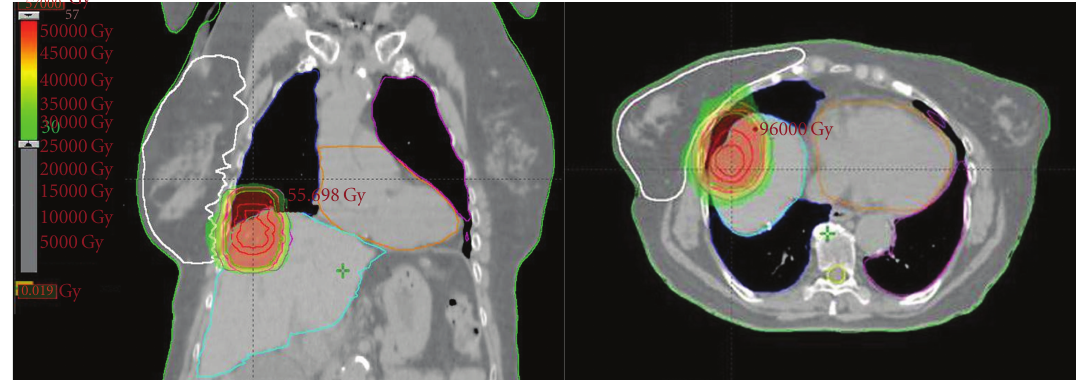
Figure 1: Distribution of isodoses with HT treatment planning in the patient 8 (hepatic dome metastasis) in axial and frontal representation. The di ff erent doses as well as the target volumes/organs at risk are represented with di ff erent colors. Red color represents the target volume dose ( > 54Gy). Green color represents lower radiation doses of 30